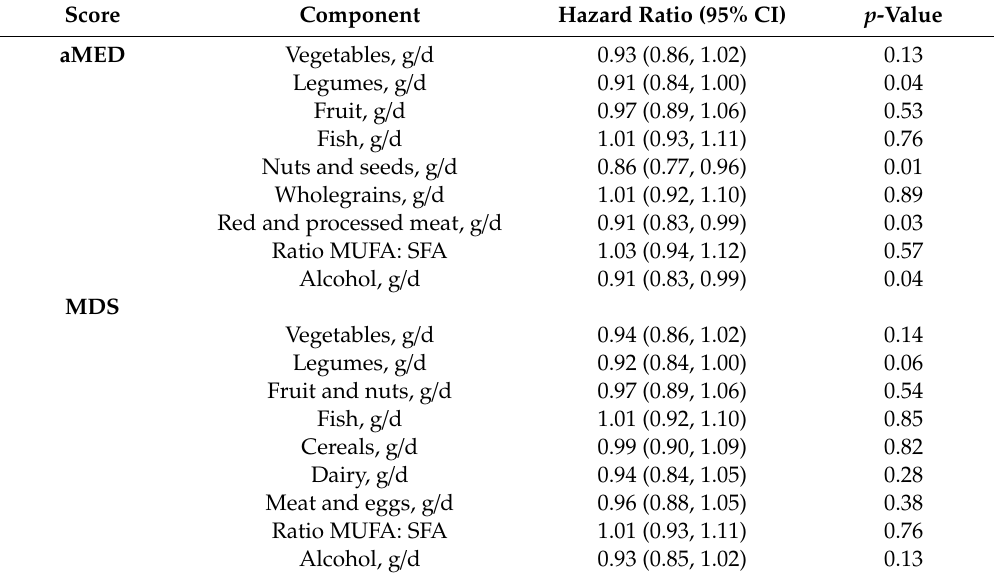
Table 2. Total fracture risk after a mean follow up of 17.6 years by individual components of the alternative Mediterranean Diet Score and Mediterranean Diet Score in 25,450 men and women aged 39–79 years 1